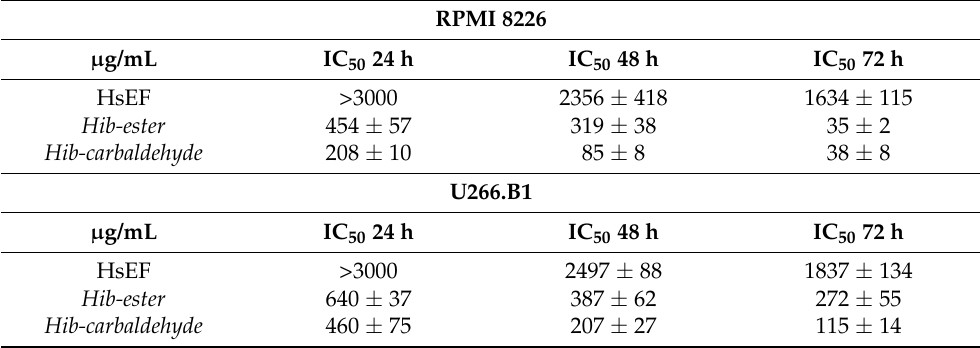
Table 2. IC 50 of RPMI 8226 and U266.B1 cells after treatment with HsEF, HE and HC.